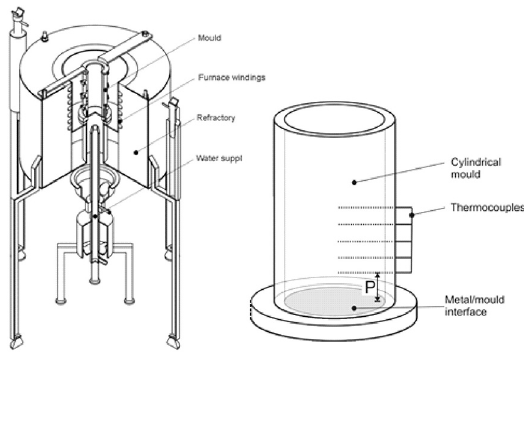
Figure 1: Schematic vertical upward directional solidification casting assembly and mold details (right side). with different solidification conditions for CET analysis as follows: G1: bottom part of the mold in graphite; ΔT~40K; S1: bottom part of the mold in low carbon steel; Δ T~80K and S2: bottom part of the mold in low carbon steel;